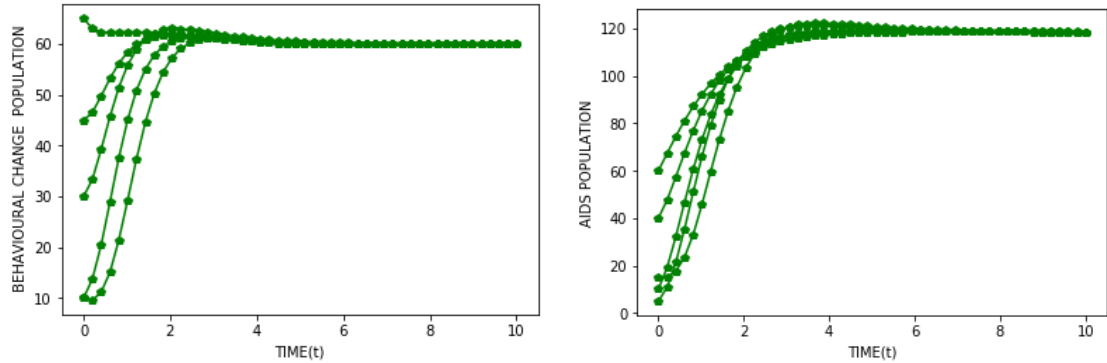
Fig. 12 and Fig. 13 Showing The Behavior of Both Fast Progression and AIDS Populations when R T is Greater Than